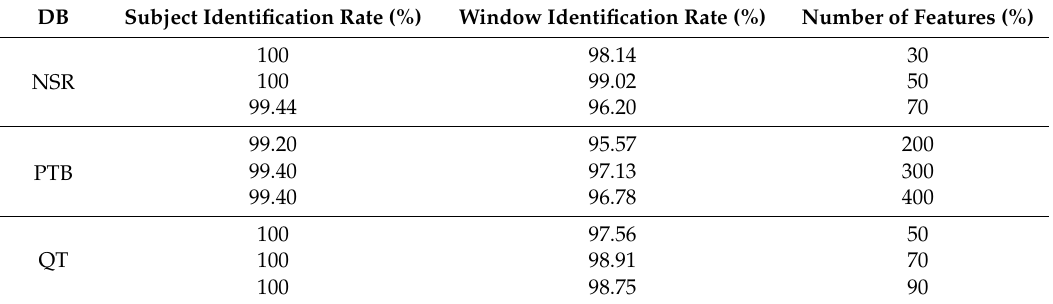
Table 3. Comparison of results according to the number of features with nearest neighbor (NN).